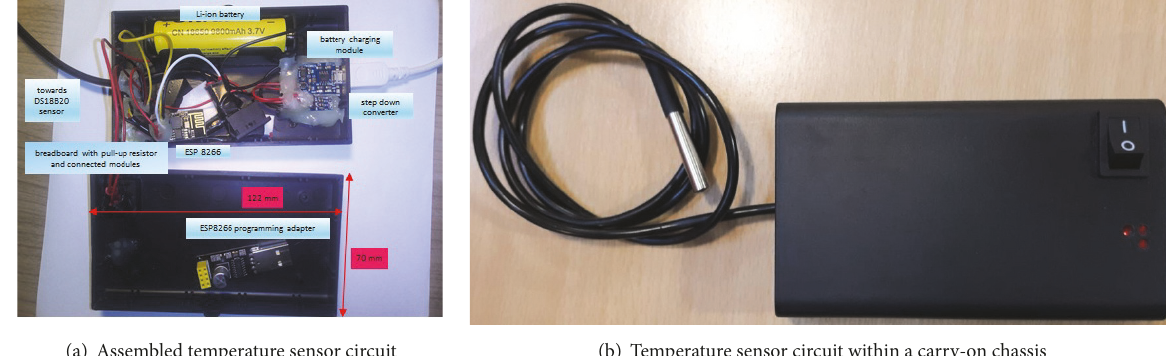
Figure 8: An early standalone circuit of a temperature sensor that is capable of real-time data publishing: (a) assembled circuit; (b) the circuit within a carry-on box.